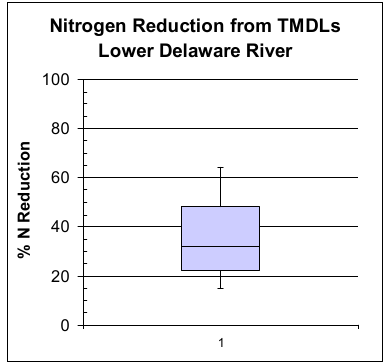
Figure 5. Nitrogen load reductions from Total Maximum Daily Load (TMDL) models for the lower Delaware River [44].